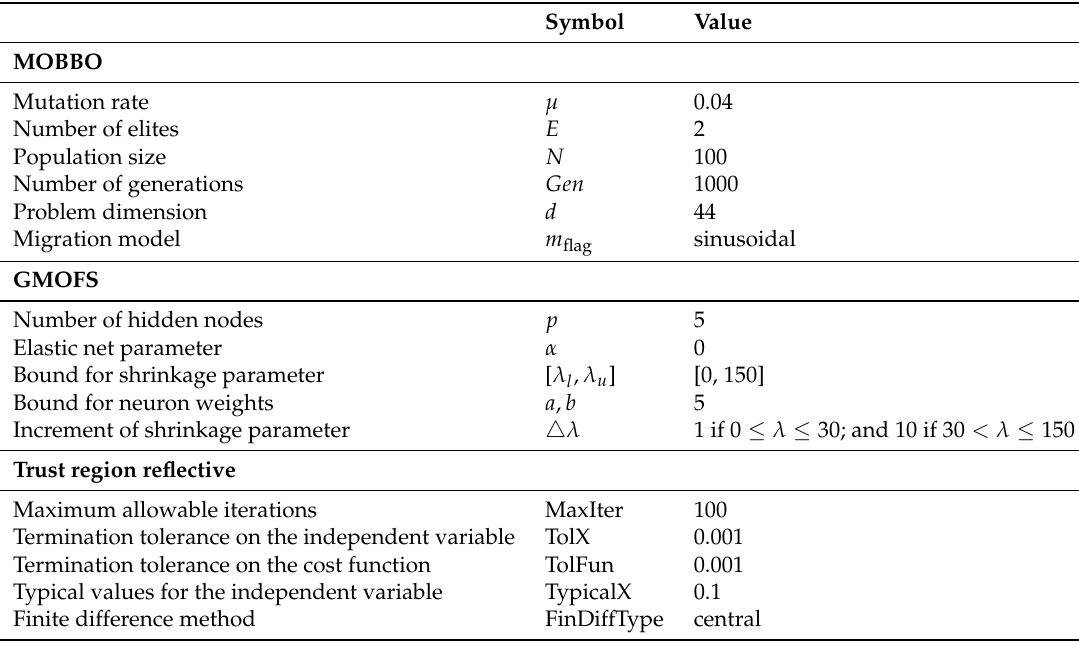
Table 3. Tuning parameters for multi-objective feature